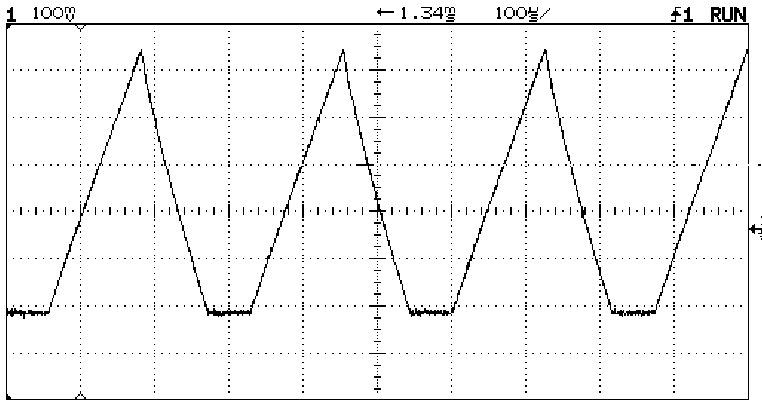
Figure 8. Inductor current for one of the AEQ units. Vertical: 2 Amps/div, Horizontal: 100 us/div.